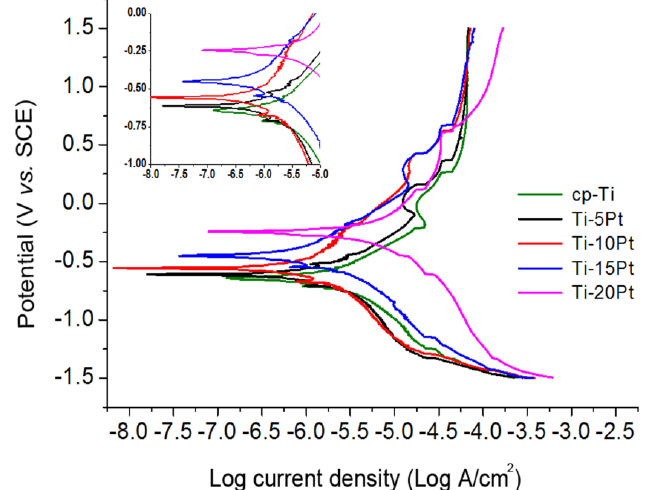
Figure 5. Representative potentiodynamic polarization curves for cp-Ti and Ti-xPt alloys. Inset shows enlarged polarization curve segments at the corrosion